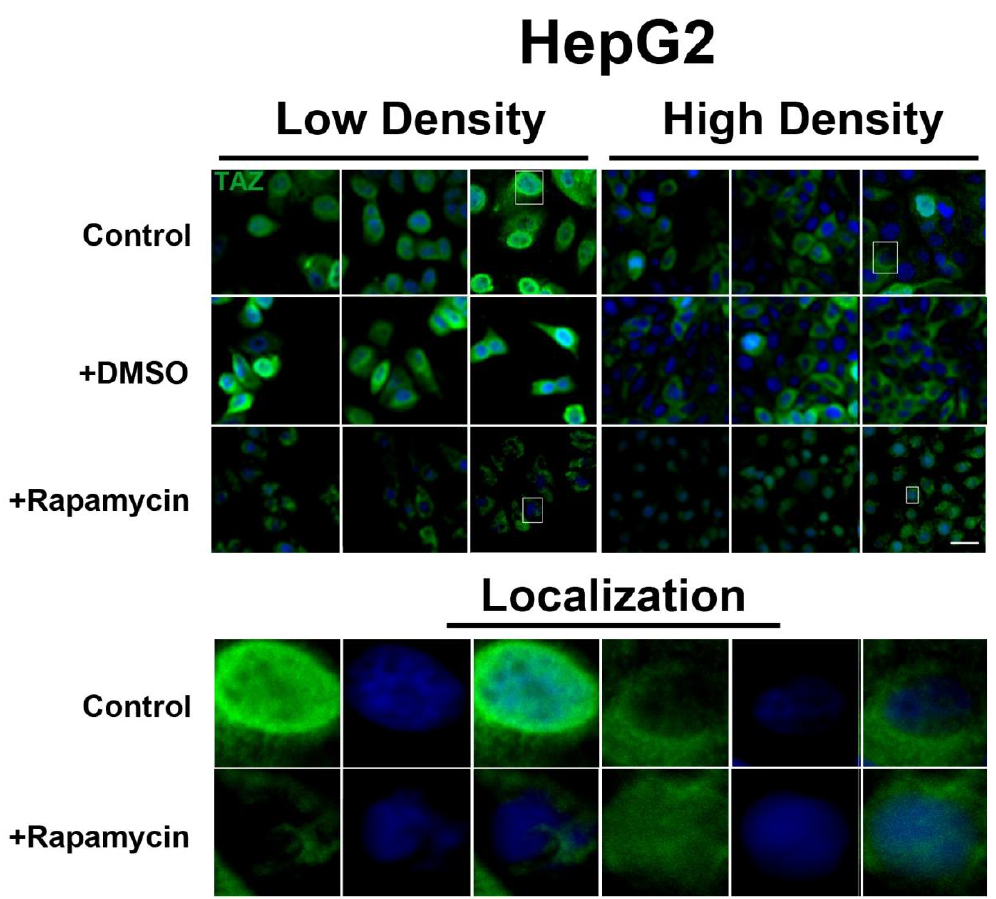
Figure 5. mTOR pathway inhibition affects expression and localization of TAZ in HepG2 cells. Decreased levels of TAZ (green) were observed at both high and low cell densities after treatment with rapamycin. Bottom panels represent the boxes in top images: localization of TAZ at low cell density conditions demonstrates mostly nuclear expression that becomes cytoplasmic upon rapamycin treatment, while in high density conditions, TAZ is mostly cytoplasmic in control cells but shifts to the nucleus upon rapamycin treatment. TOPRO3 (blue) labels nuclei. Scale bars, 20